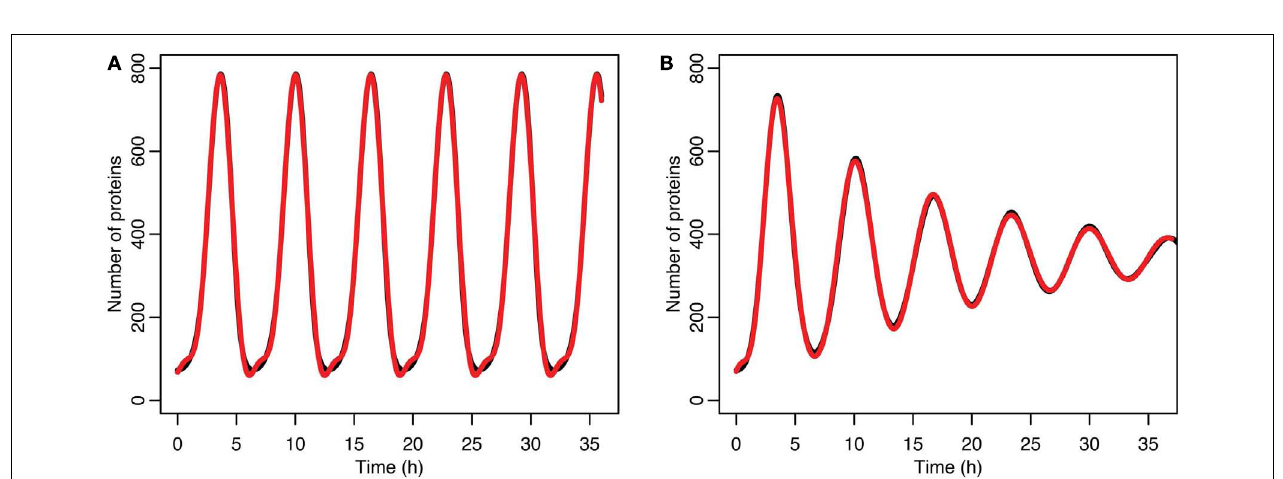
FIGURE 6 | Comparison of stochastic and deterministic models. (A) Shows the comparison for MDM2 with MDM2 from the deterministic model in red and from the mean of 5,000 runs of the